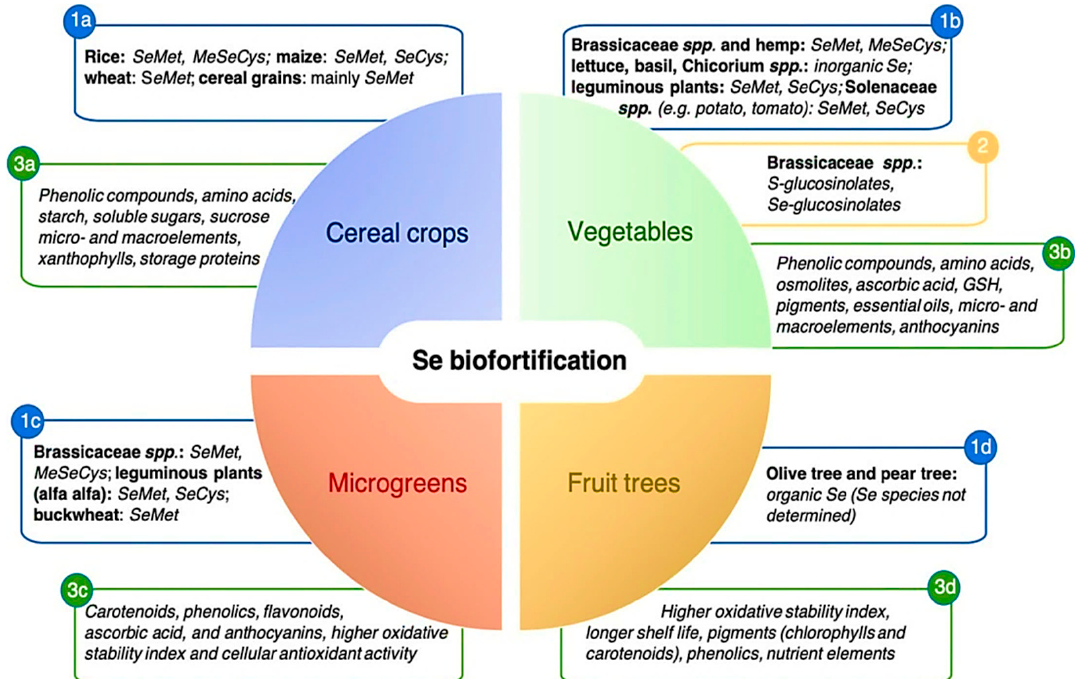
Figure 3. Se biofortification to improve human plant-foods [244]. Note: (1a), (1b), (1c) and (1d) indicate that SeMet, MeSeCys, SeCys contents are available in cereals, vegetables, fruits, and microgreens; (2) indicate that S-glucosinolate and Se- glucosinolate content are available only in vegetables and (3a), (3b), (3c) and (3d) indicate that phenolic compounds, amino acids, starch, soluble sugars, sucrose, micro-and macro-elements, antioxidants, storage protein etc. are available in cereals, vegetables, fruits, and microgreens.